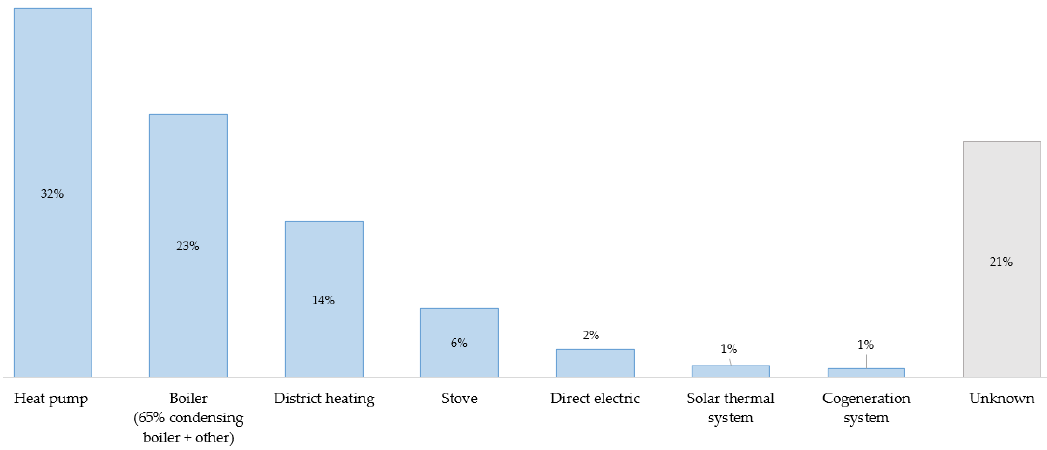
Figure 15. Share of systems to produce heating and DHW in the selected nZEBs.